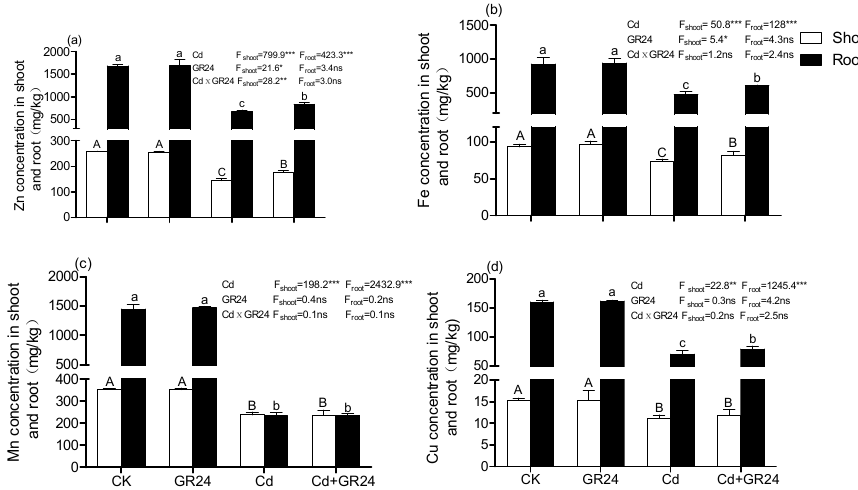
Figure 3. The effects of GR24 on ( a ) Zn (zinc), ( b ) Fe (iron), ( c ) Mn (manganese), and ( d ) Cu (copper) uptake in shoots and roots. Values shown as means ± SD ( n = 3). Lower case letters represent significant differences in roots; upper-case letters represent significant differences in shoots. Different letters above the bars were significantly different at the 0.05 level (Duncan’s test), ns: not significant, * p < 0.05, ** p < 0.01, *** p < 0.001.